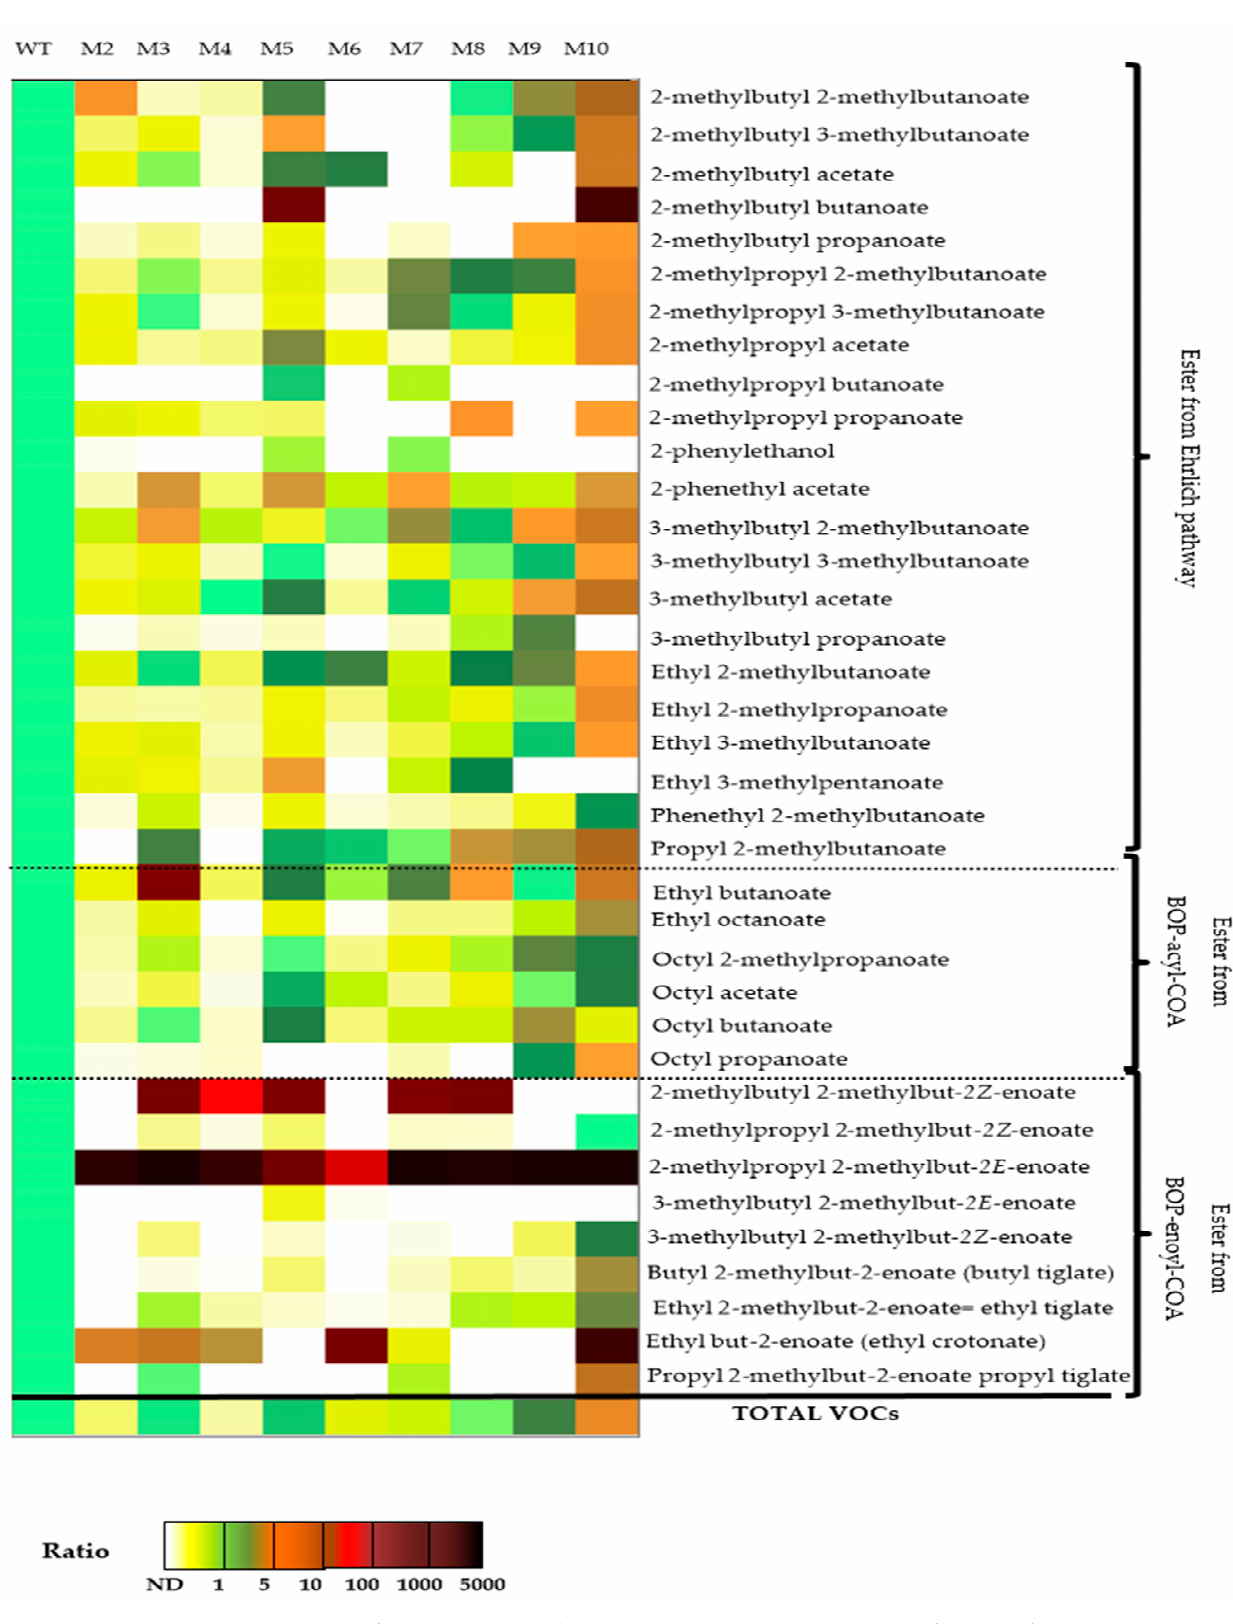
Figure 6. Heatmap representation of VOCs determined in the wild-type and 9 ILV mutants of S. suaveolens obtained by UV mutagenesis. Data are represented as ratio of the VOCs value in the mutant versus in the wild-type. VOCs were classified as mainly derived from Ehrlich pathway (EP), from acyl-CoA or enoyl-CoA intermediates of the β -oxidation pathway.